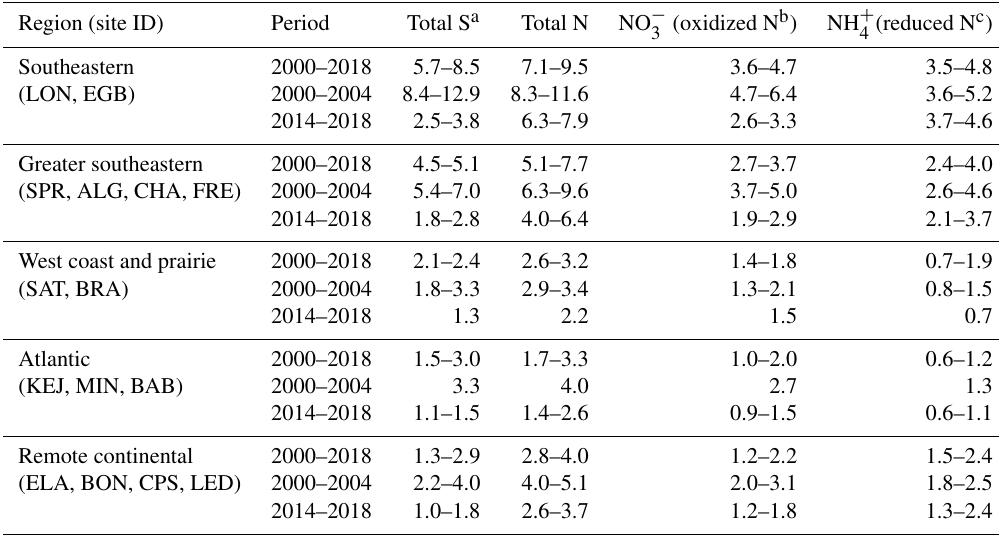
Table 5. Regional breakdown of mean total (dry + wet) N and S deposition fluxes (kgN or Sha − 1 yr − 1 ) across Canada. Regional values are based on deposition fluxes from representative CAPMoN sites.